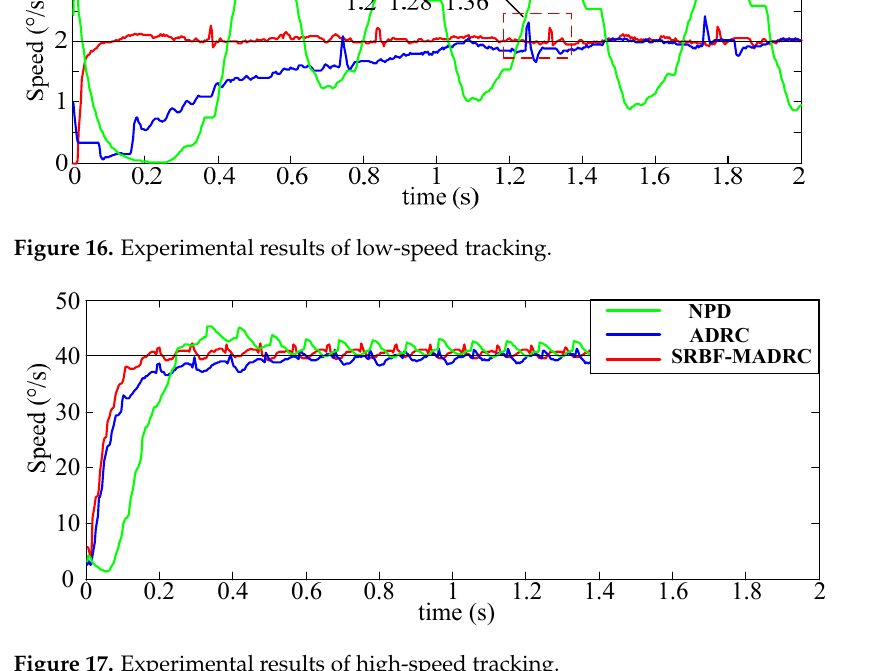
Figure 17. Experimental results of high-speed tracking. Table 3. Performance comparison of three algorithms.